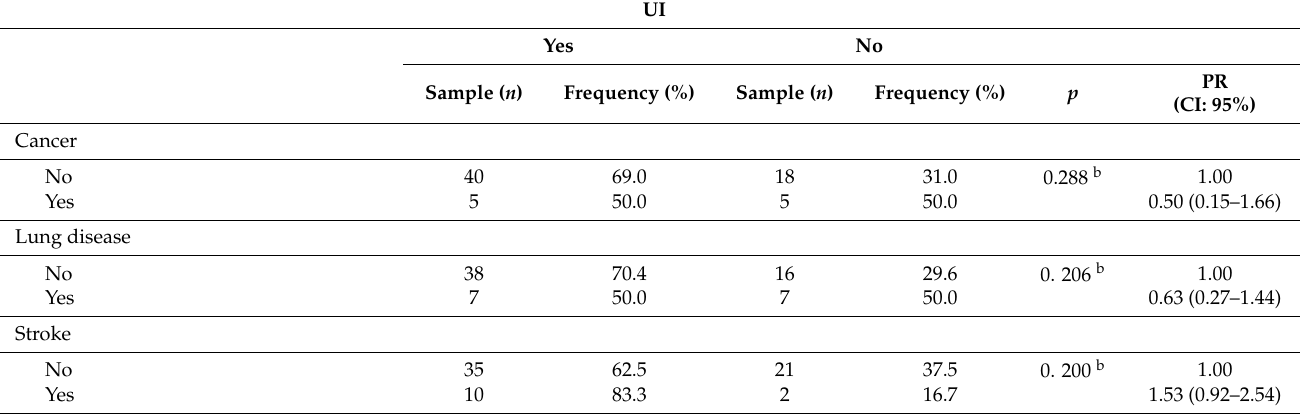
Table A1. Non-significant results between UI (according to the MDS) and categorical independent variables with p value over 0.200 among 68 residents living in five nursing homes (NHs) from Osona, Spain